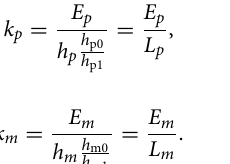
The elastic forces per unit area of the particle and matrix for the top and bottom parts are given as: